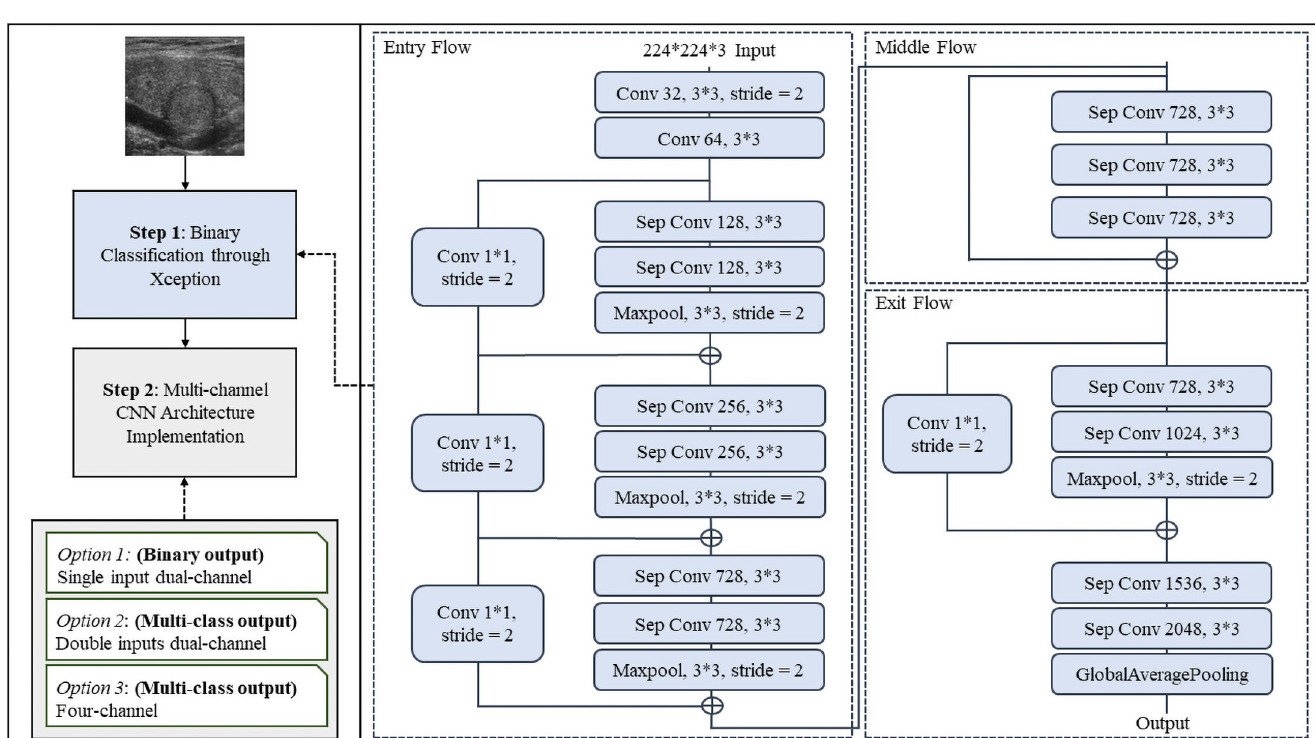
Fig 2. Multi-channel Xception-based thyroid cancer detection